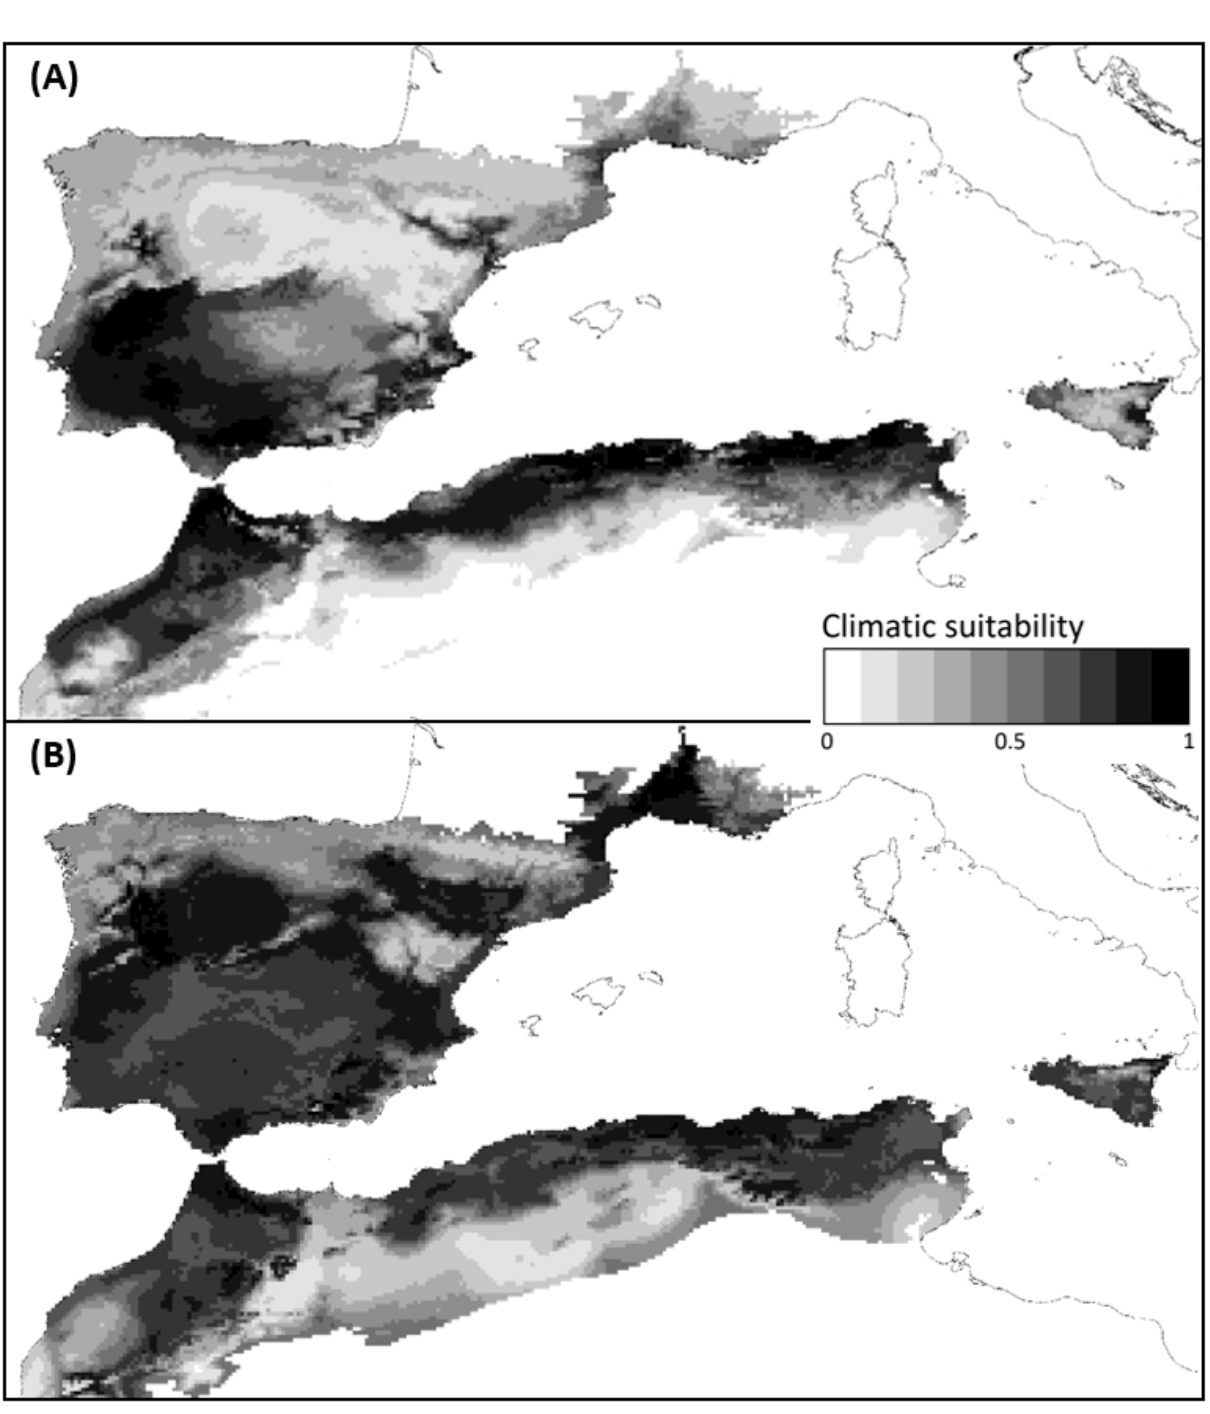
Figure 3. Current ( A ) and future ( B ) climatic suitability predictions for Discoglossus pictus in northern Africa and southern Europe. Future climatic predictions are based on the optimistic greenhouse gas scenario (RCP 2.6).